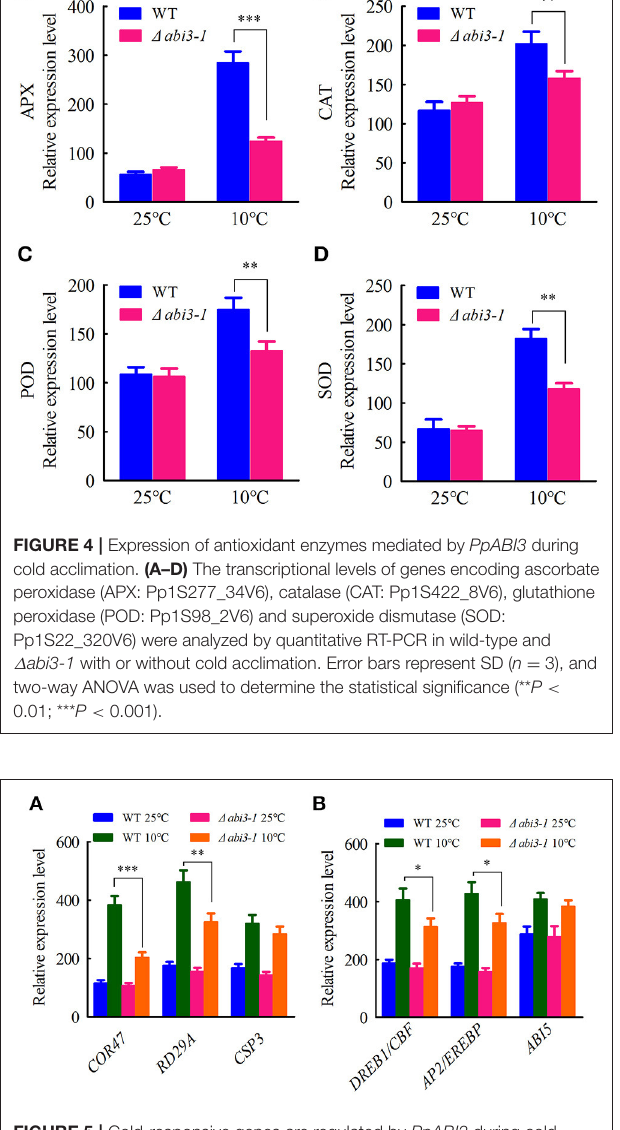
FIGURE 5 | Cold-responsive genes are regulated by PpABI3 during cold acclimation. (A) Relative transcription of three cold responsive genes. The transcriptional levels of three genes: PpCOR47 (Dehydrin-coding gene: Pp1s442_22V6.2), PpRD29A (Desiccation-responsive protein 29A: PP1S203_40V6.1) and PpCSP3 (Cold shock protein: Pp1s103_65V6.1) were analyzed by quantitative RT-PCR. (B) Relative transcription of representative transcription factors. The transcriptional levels of three cold responsive transcription factors: DREBP1/CBF (DRE/CRT binding factor: Pp1s60_228V6.1), AP2/EREBP (APETALA2/ethylene-responsive element binding protein: Pp1s373_18V6.1) and ABI5 ( ABSCISIC ACID INSENSITIVE5 : Pp1s49_161V6) were analyzed by quantitative RT-PCR. Error bars represent SD ( n = 3), and two-way ANOVA was used to determine the statistical significance (* P < 0.05; ** P < 0.01; *** P <